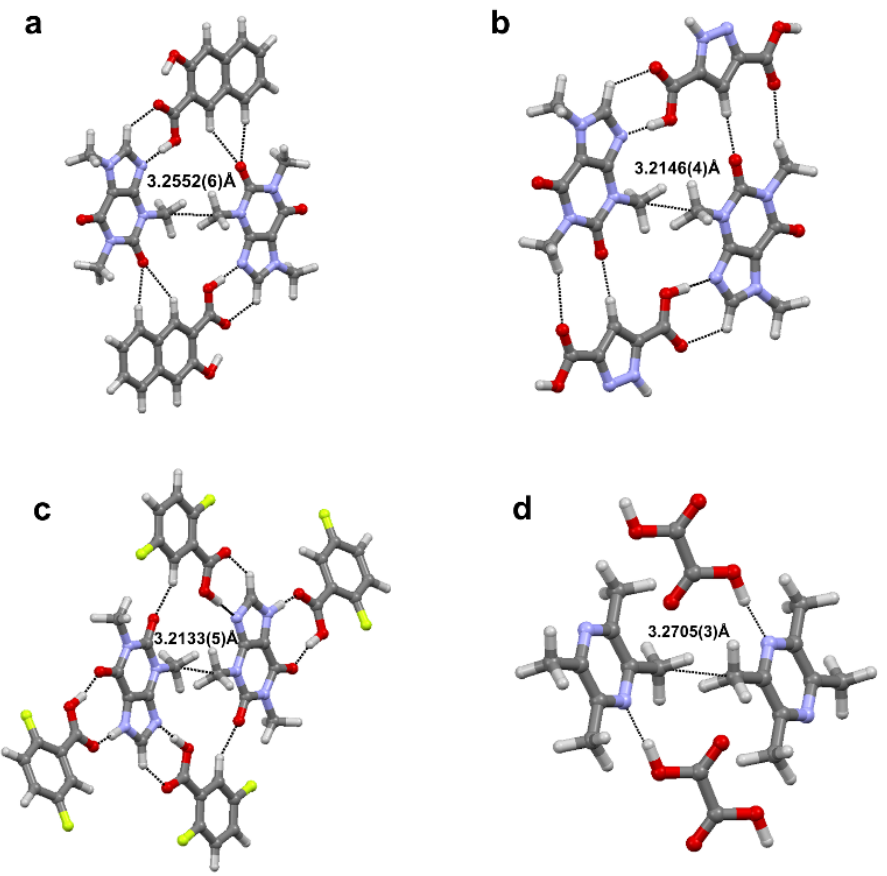
Figure 15. Me ··· Me HI motif in the four cocrystals. ( a ) Caffeine:3-hydroxy-2-naphthoic acid (Caff- 3HNA), ( b ) caffeine:3,5-pyrazoledicarboxylic acid (Caff-PZCA), ( c ) theophylline:2,5-diflurobenzoic acid (Theo-25DFBZA) and ( d ) 2,3,5,6-tetramethylpyrazine: oxalic acid (TMP-OA).